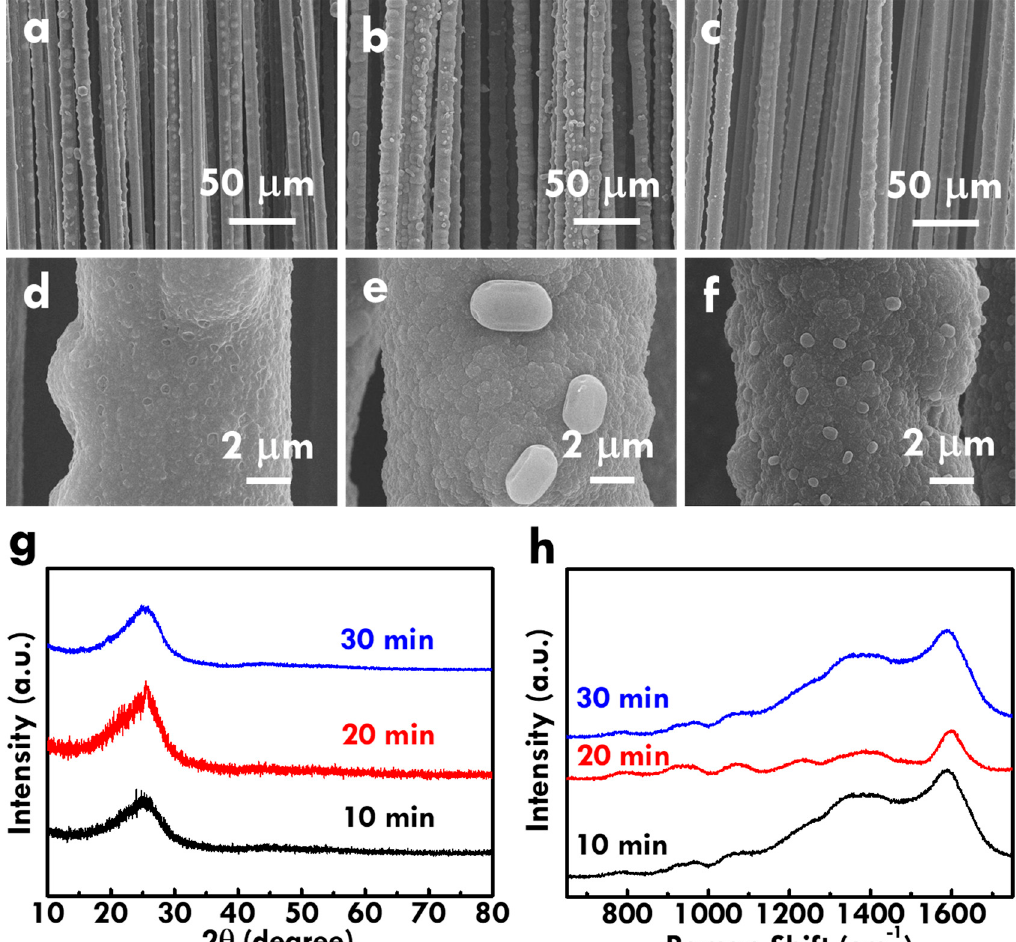
Figure 3. The SEM images for the CF@PPy prepared using electropolymerization times of ( a , d ) 10, ( b , e ) 20, and ( c , f ) 30 min; ( g ) the XRD patterns and ( h ) Raman spectra for the CF@PPy prepared using different electropolymerization times.